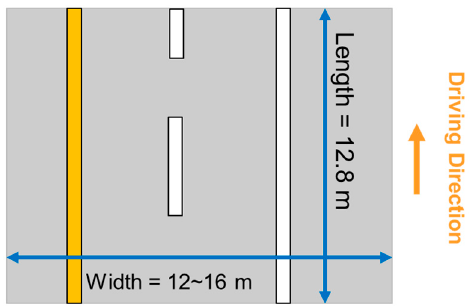
Figure 9. Schematic diagram of a road surface point cloud block used for intensity image generation.